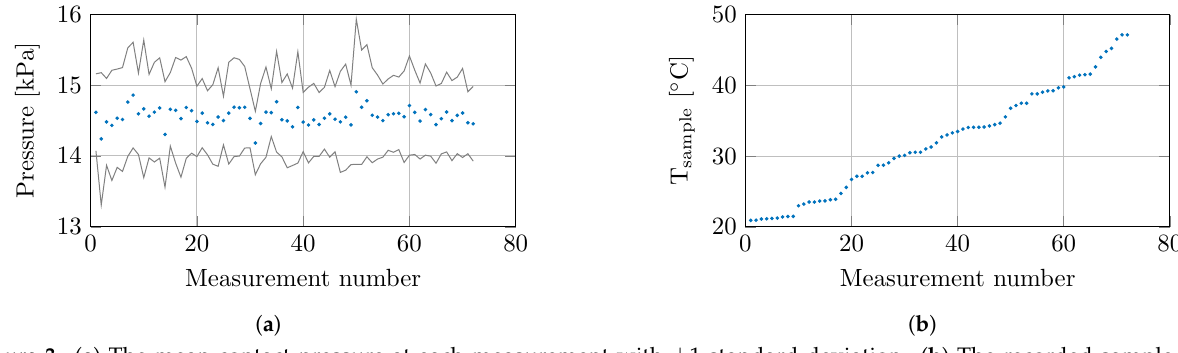
1 standard deviation. ( b ) The recorded sample ±